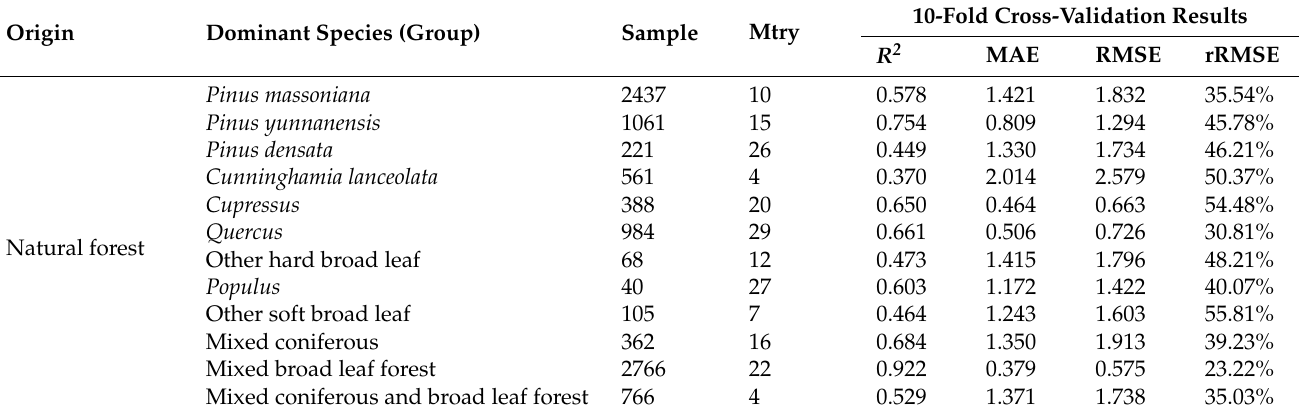
Table A4. Optimal model evaluation indicators of volume gross growth of dominant tree species (group) in natural and planted